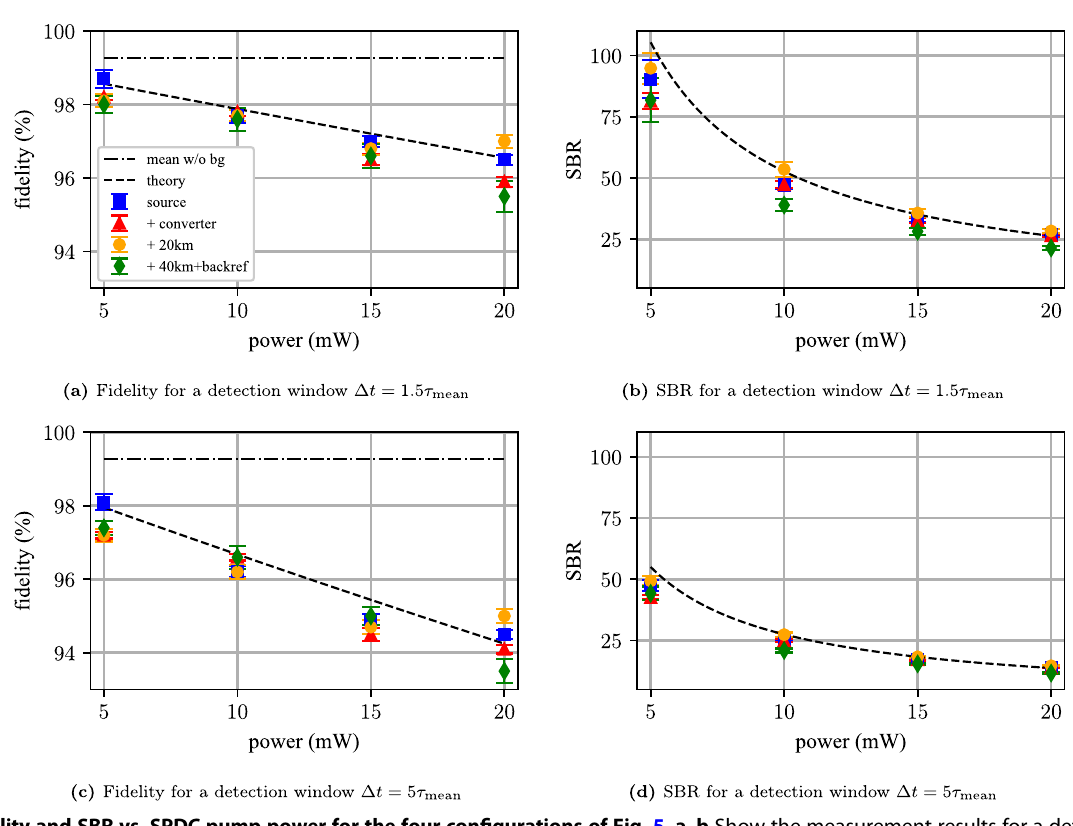
Fig. 6 Fidelity and SBR vs. SPDC pump power for the four con fi gurations of Fig. 5. a , b Show the measurement results for a detection time window of 1.5 τ mean which corresponds to 78% of the photon temporal shape. In ( a ) the non background corrected MLE results are represented by the data points, the dot-dashed line shows the mean background corrected fi delity, while the dashed line shows the theoretical expectation according to Eq. (5). The uncertainties are derived from a simulation; see “ Method ” section for further details. b Shows the comparison of the SBR for the four different measurement settings. The dashed line is calculated for the given pair rate according ffiffiffiffi p N to Eq. (4). The error bars are calculated by including the -noise of the measured coincidences 59 . c , d Show the results when choosing a larger detection window of 5 τ mean for the